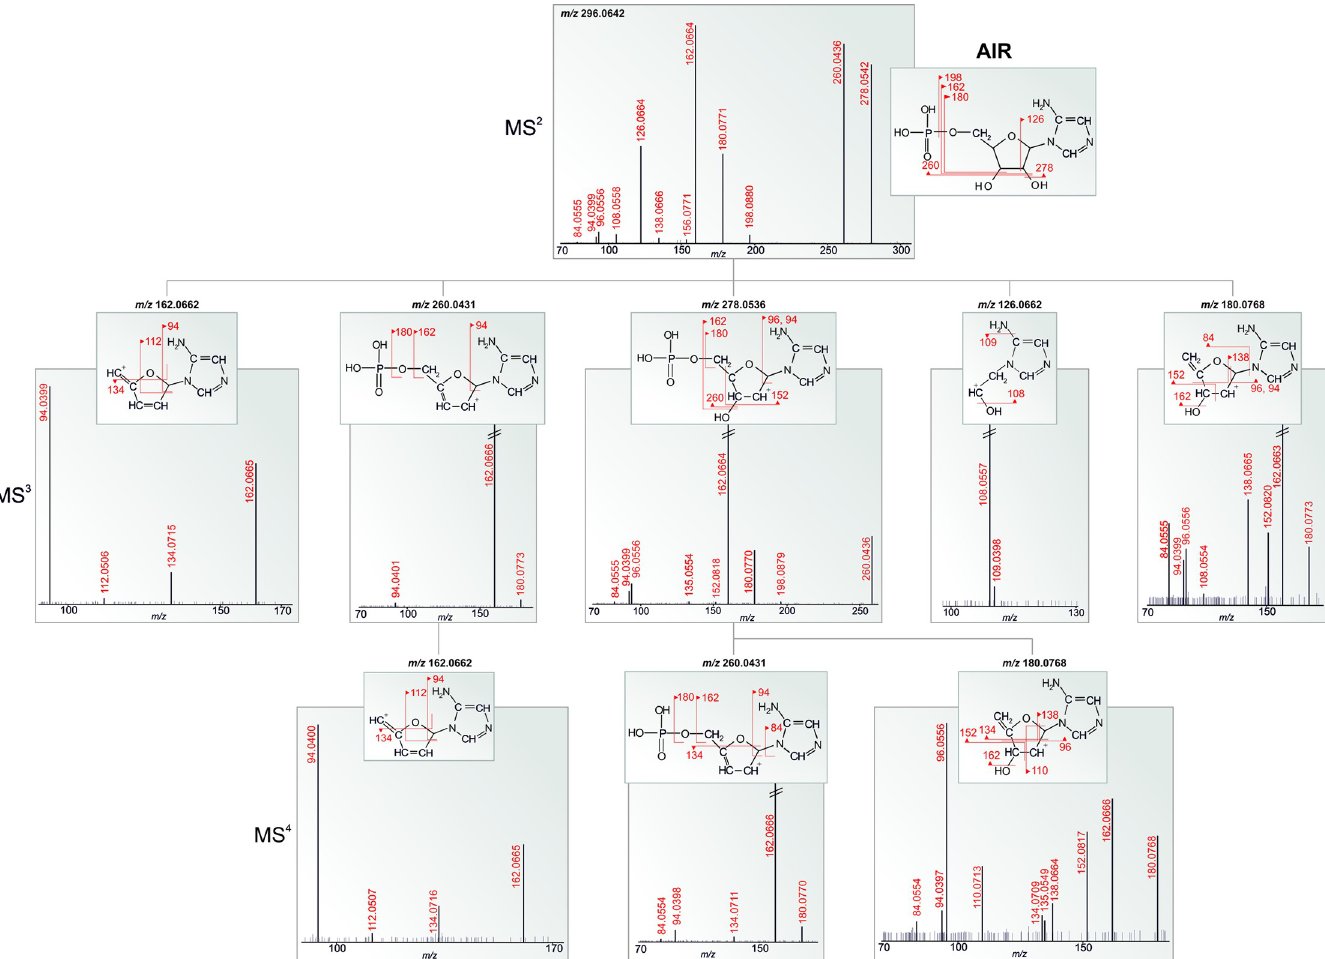
Fig 2. Fragmentation spectral tree of AIR. Every m/z assigned with accurate mass in the spectra (in red) belongs to the fragmented structure. The other m/z represent coeluting compounds or masses belonging to the fragmented structure that could not be identified using the given procedure.